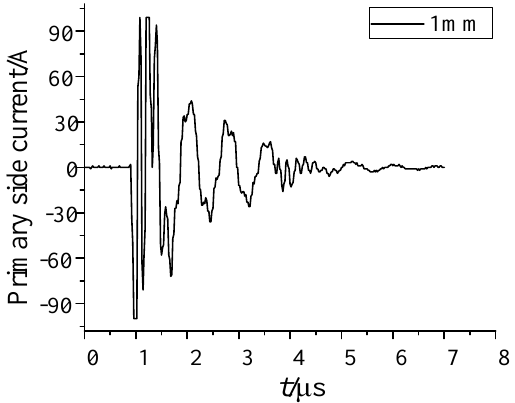
6 of 15 Figure 7. Schematic diagram of magnetic field measurement position. 3. Analysis of Test Results When the voltage at both ends of the ball gap fracture reached the breakdown volt-